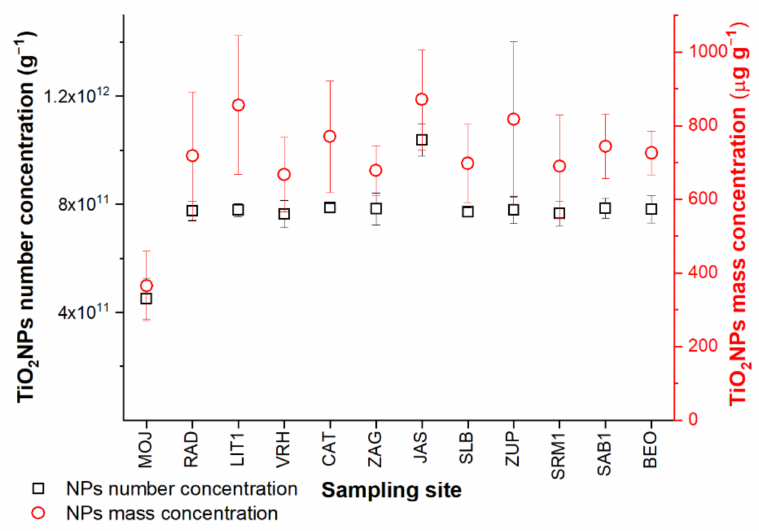
Figure 3. Mass and number concentration of TiO 2 NPs determined in sediment extracts from 12 dif- ferent locations of the Sava River. Data represent the mean ± STD of six replicates (N = 6). The results show how the TiO 2 NPs concentrations did not differ among sampling locations (from 365 ± 94 µ g/g at MOJ to 871 ± 136 µ g/g at JAS) as much as in river water (Figure 2). Similar to the water samples, the lowest TiO 2 NPs concentration was observed